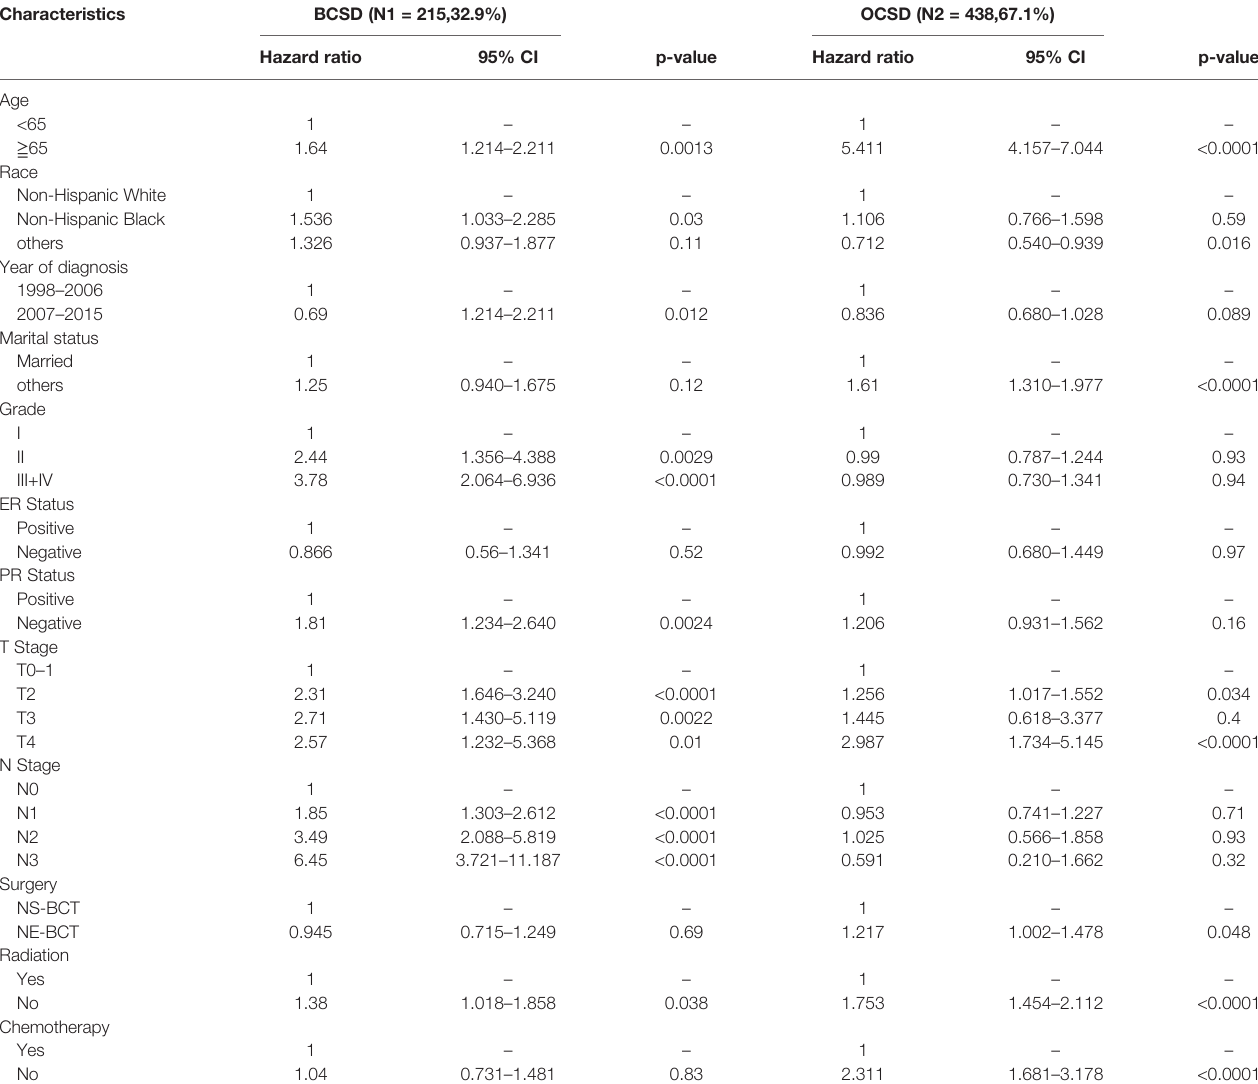
TABLE 2 | Multivariate competing risk regression model